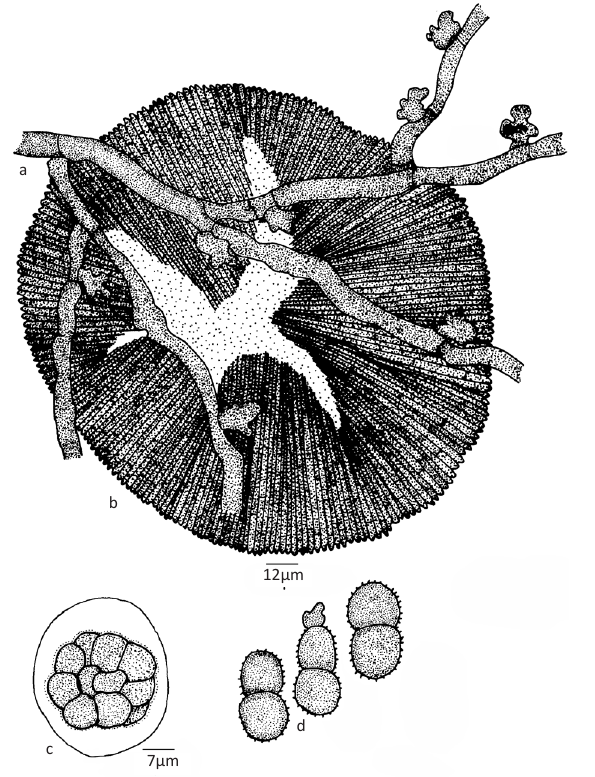
Figure 1. Asterina antidesmatis a - Appressoriate mycelium; b - Thyriothecium; c - Ascus; d -